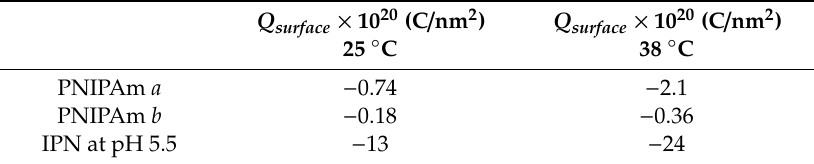
Table 4. Charge density at the microgel surface calculated at 25 ◦ C and 38 ◦